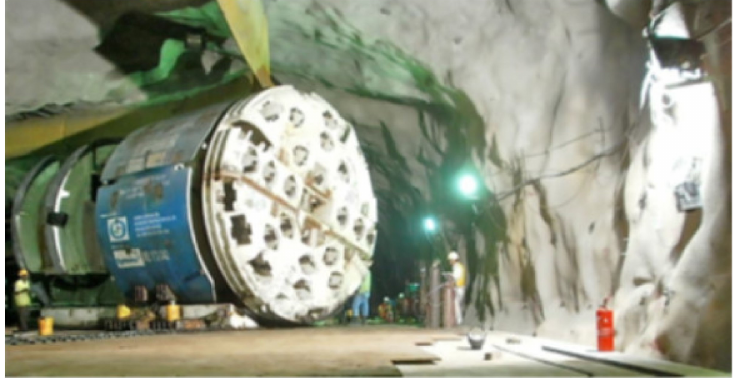
Figure 1. Robbins 5.2 m diameter main beam Tunnel Boring Machine